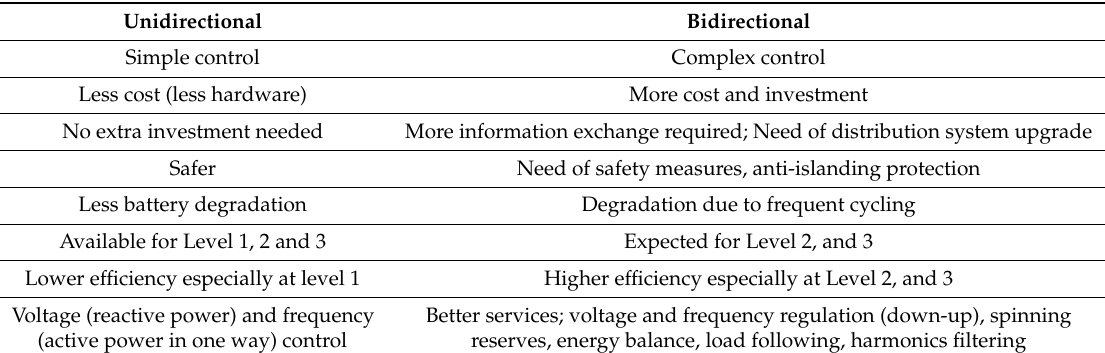
Table 3. Comparison between unidirectional and bidirectional chargers